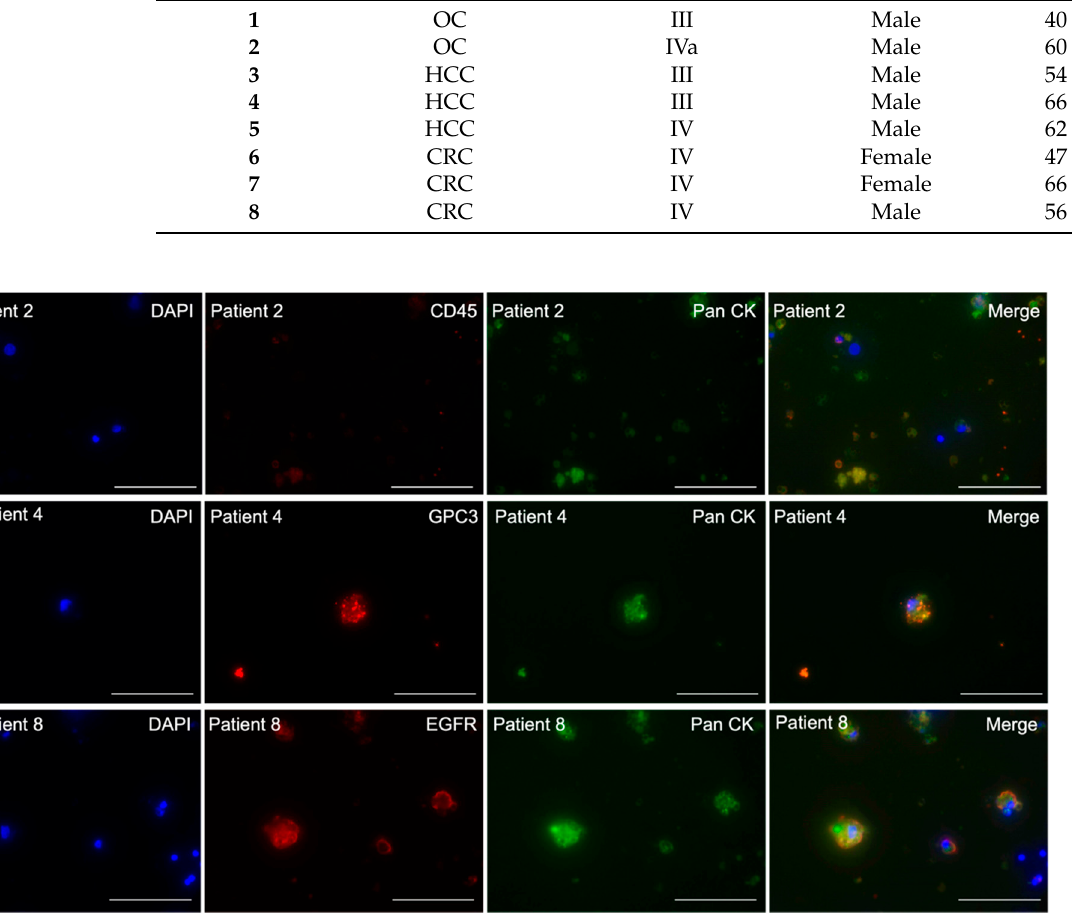
Figure 2. Immunofluorescence analysis of expanded circulating tumor cells. OC: oral cancer; HCC: hepatocellular carcinoma; CRC: colorectal cancer. PanCK is a cancer-specific surface marker. CD45, GPC3, EGFR are markers specific to leucocytes, HCC, and CRC, respectively. Representative images from one patient in each cancer type is shown. The scale bar is 75 µm in length.